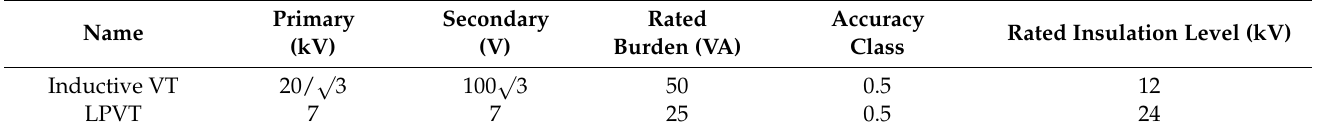
Table 3. Rated characteristics of the investigated instrument transformers.